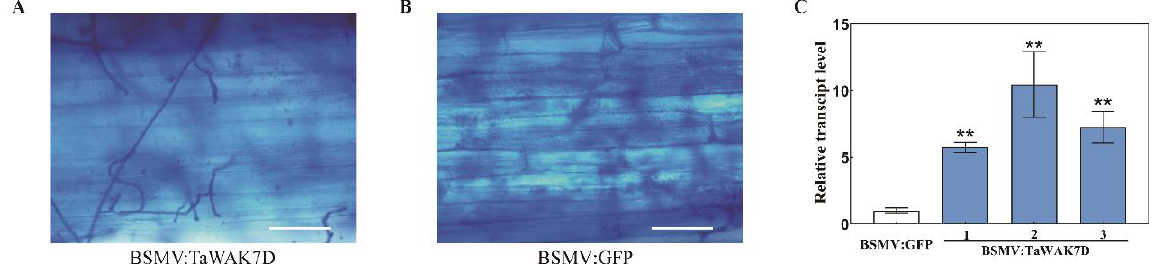
Figure 6. Trypan blue staining and RcActin transcript level in BSMV:TaWAK7D- and BSMV:GFP-infected wheat CI12633 plants. Trypan blue staining for the detection of the R. cerealis hyphae on the base leaf sheath of the BSMV:TaWAK7D ( A ) and BSMV:GFP ( B ) inoculated CI12633 plants at 4 dpi with R. cerealis Rc207. Bar = 20 μm. ( C ) qRT-PCR analysis of RcActin gene in stems of BSMV:TaWAK7D- and BSMV:GFP-infected wheat CI12633 plants at 10 dpi with R. cerealis . RcActin transcription represents the relative biomass of R. cerealis. Significant differences were determined based on three technical repeats ( Student’s t-test: ** p < 0.01). The expression level of RcActin in BSMV:GFP-infected wheat CI12633 plants was set to 1.